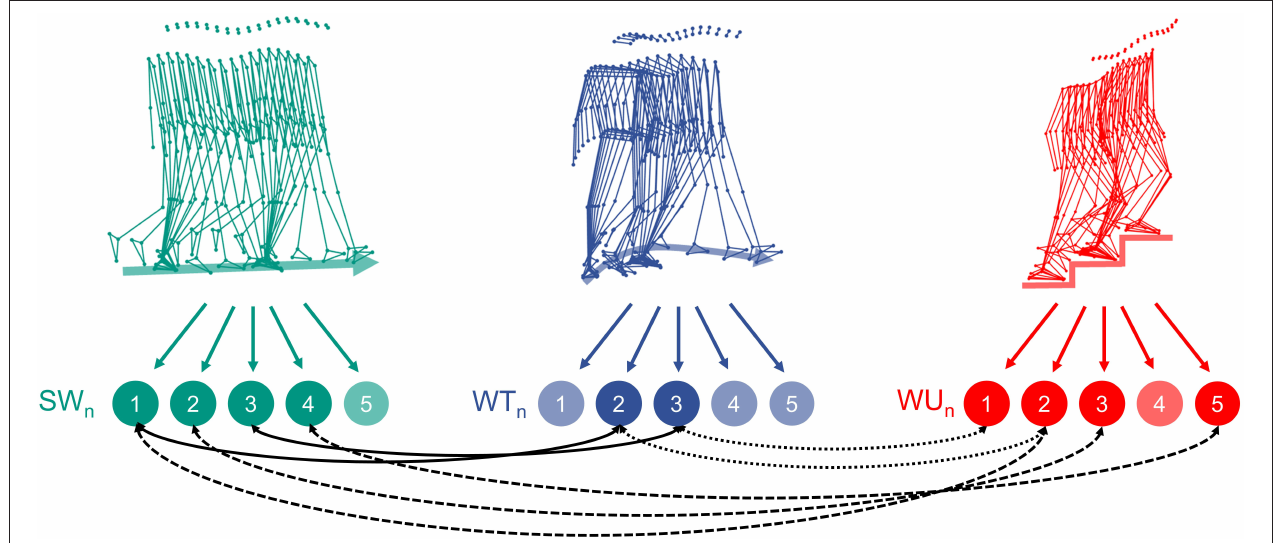
FIGURE 2 | Schematic representation of the three locomotion tasks (SW, straight-line walking; WT, walking 90 ◦ spin turn; WU, walking upstairs) and their decomposition into five main kinematic synergies. The black arrows highlight high similarities (cosine similarity > 0.80) across the different locomotion